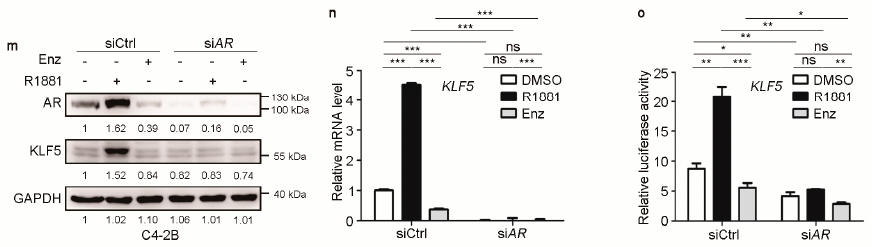
Figure 1. Androgen-androgen receptor (AR) signaling upregulates the transcription of KLF5 in PCa cells. ( a – d ) R1881 induced the expression of KLF5 at both protein (a, c) and RNA (b, d) levels in LNCaP (a, b) and C4-2B (c, d) cells. After 24-hour culture in phenol red–free RPMI-1640 medium containing 10% charcoal-stripped (CS) FBS, cells were treated with R1881 for 24 h at the indicated concentrations. Western blotting and real-time qPCR were performed to detect protein and mRNA respectively. ( e , f ) R1881 induced the expression of KLF5 at both protein (e) and RNA (f) levels at the indicated times in C4-2B cells. Cell culture conditions and the detection of KLF5 protein and mRNA were the same as in panels a-d. After 24-hour culture, cells were treated with R1881 (10 nM) for the indicated times. ( g – j ) Enzalutamide inhibited the expression of KLF5 at both protein (g, i) and RNA (h, j) levels in LNCaP (g, h) and C4-2B (i, j) cells. Cells were cultured in complete media for 24 h and treated with enzalutamide at the indicated concentrations for 24 h. ( k , l ) Enzalutamide inhibited the expression of KLF5 at both protein (k) and RNA (l) levels at the indicated times in C4-2B cells. Cell culture conditions and the detection of KLF5 protein and mRNA were the same as in panels g-j. After 24-hour culture, cells were treated with enzalutamide (Enz, 10 µ M) for the indicated times. ( m , n ) RNAi-mediated silencing of AR prevented R1881 from upregulating KLF5 expression at both protein (m) and mRNA (n) levels in C4-2B cells. Cell culture conditions and the detection of KLF5 protein and mRNA were the same as in panels a-d. Transfection of siRNAs was for 6 h before R1881 treatment (10 nM). Enzalutamide (Enz, 10 µ M) was used as a control. siCtrl, control siRNA; siAR, AR siRNA. ( o ) Knockdown of AR also prevented R1881 from inducing transcriptional activity of the KLF5 promoter in C4-2B cells, as detected by the promoter luciferase reporter activity assay. Experimental conditions were the same as in panels i and j except that the reporter plasmid was co-transfected with siRNAs. ns, not significant; *, p < 0.05; **, p < 0.01; *** p <